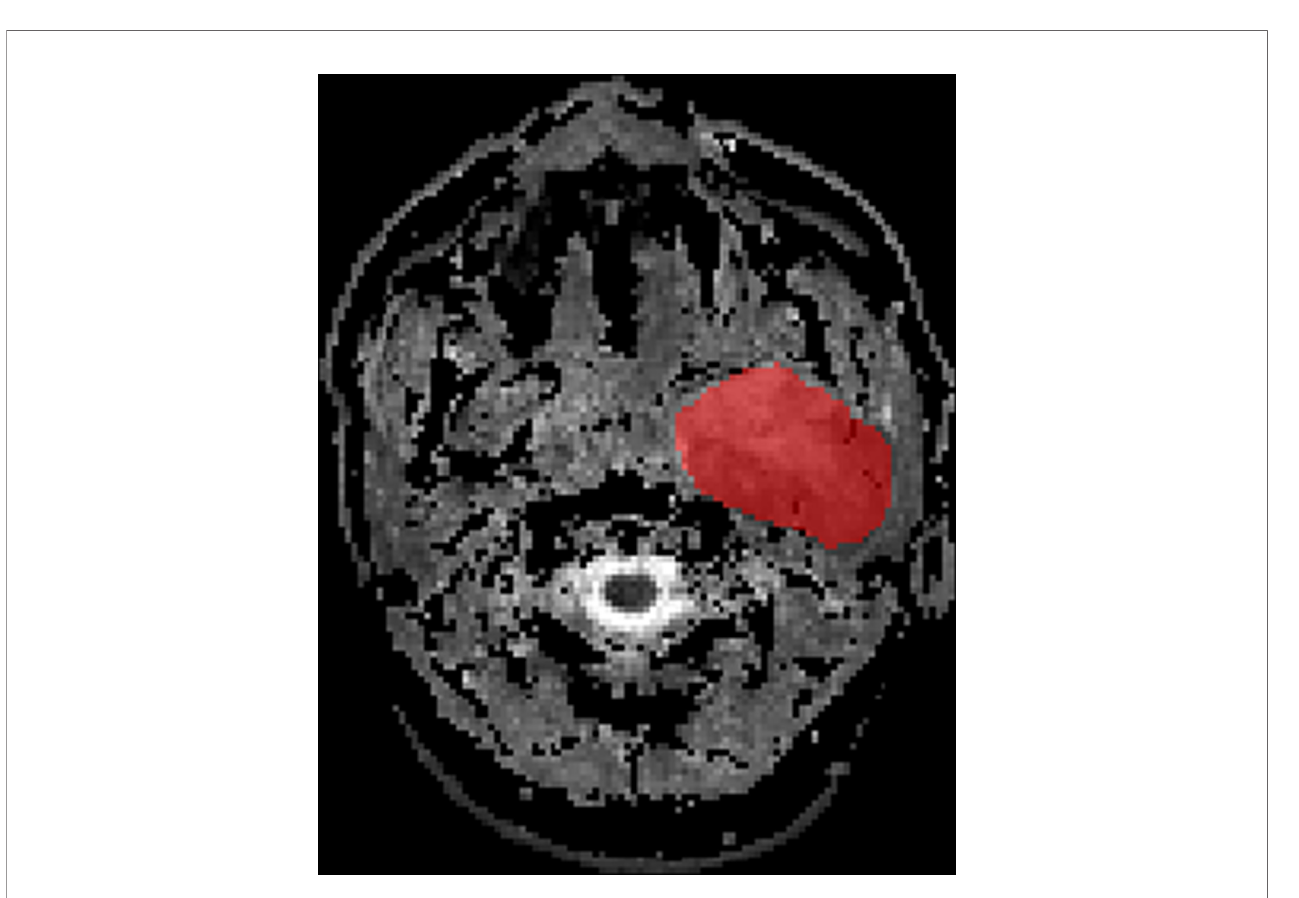
FIGURE 1 | ROI delineation of PA on ADC in ITK SNAP.